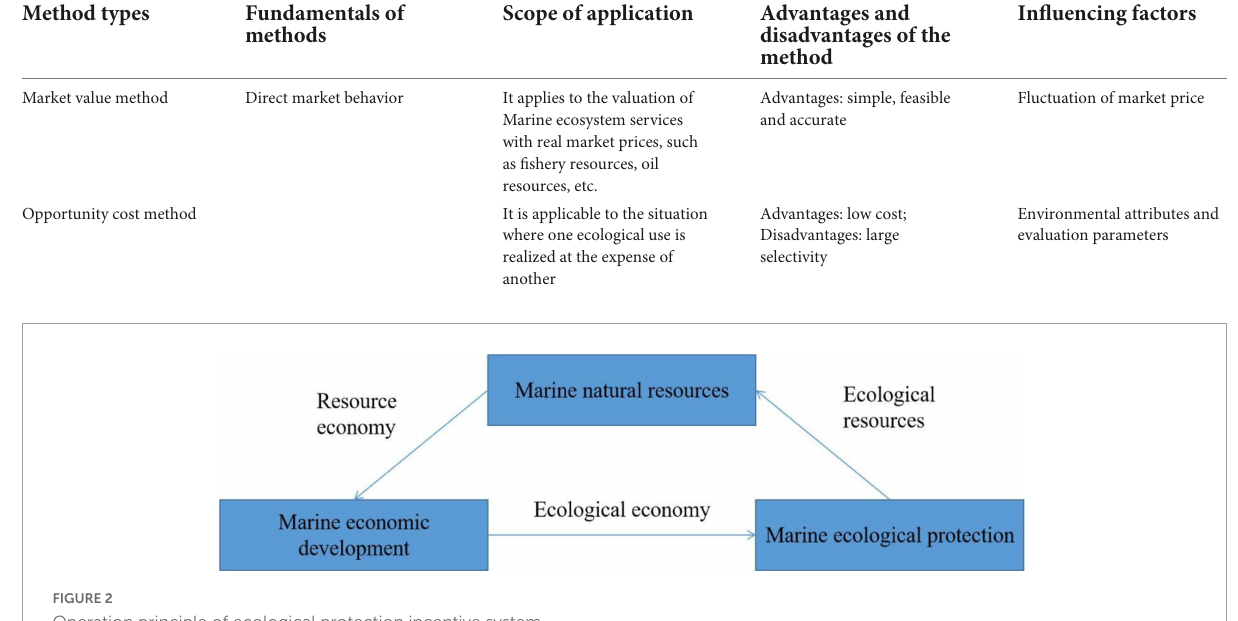
FIGURE2 Operation principle of ecological protection incentive system.